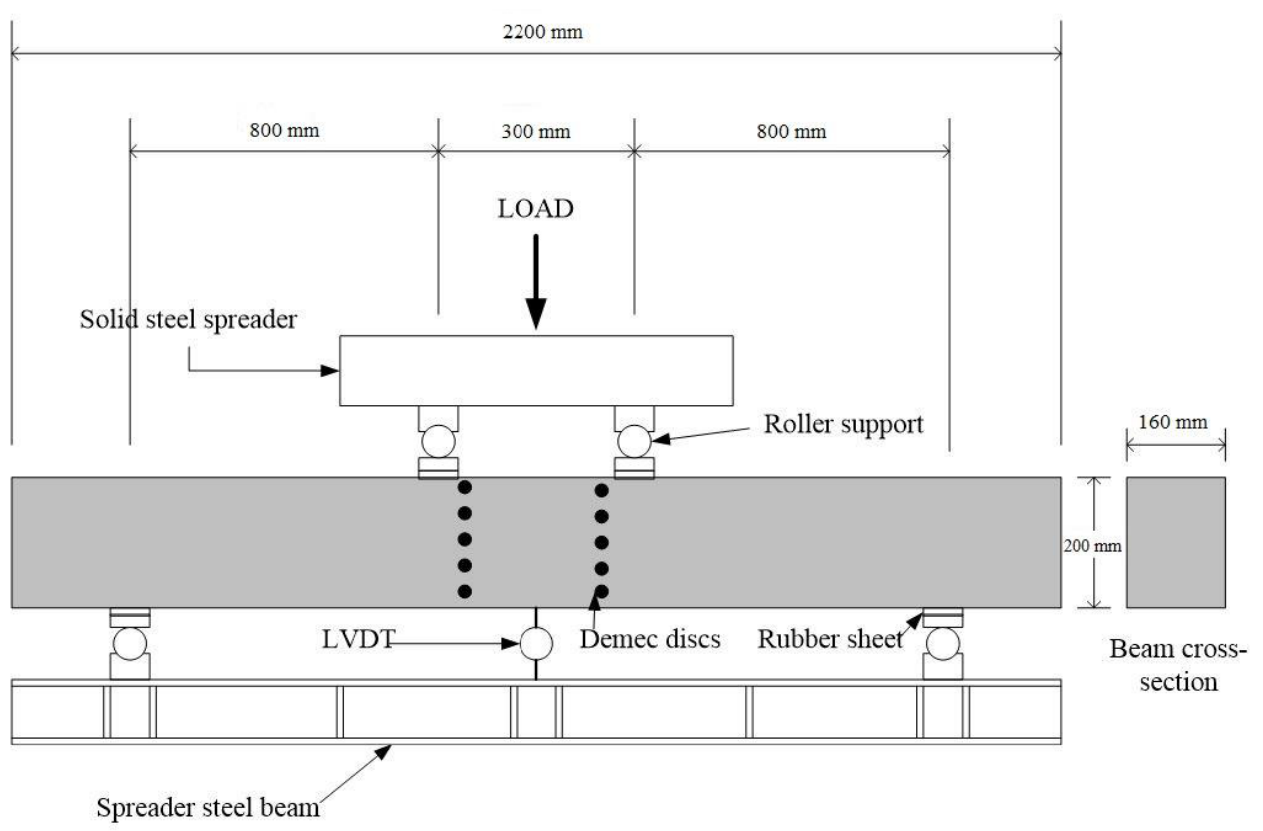
Figure 3. Arrangement of test setup of the beams.